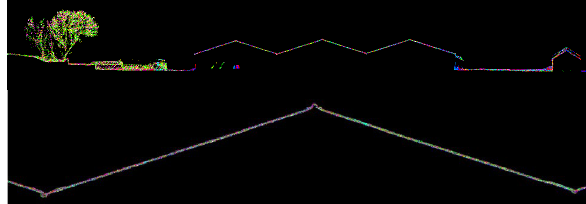
Figure 2. Strip alignment after application of roll, pitch, yaw and mirror scale shift corrections